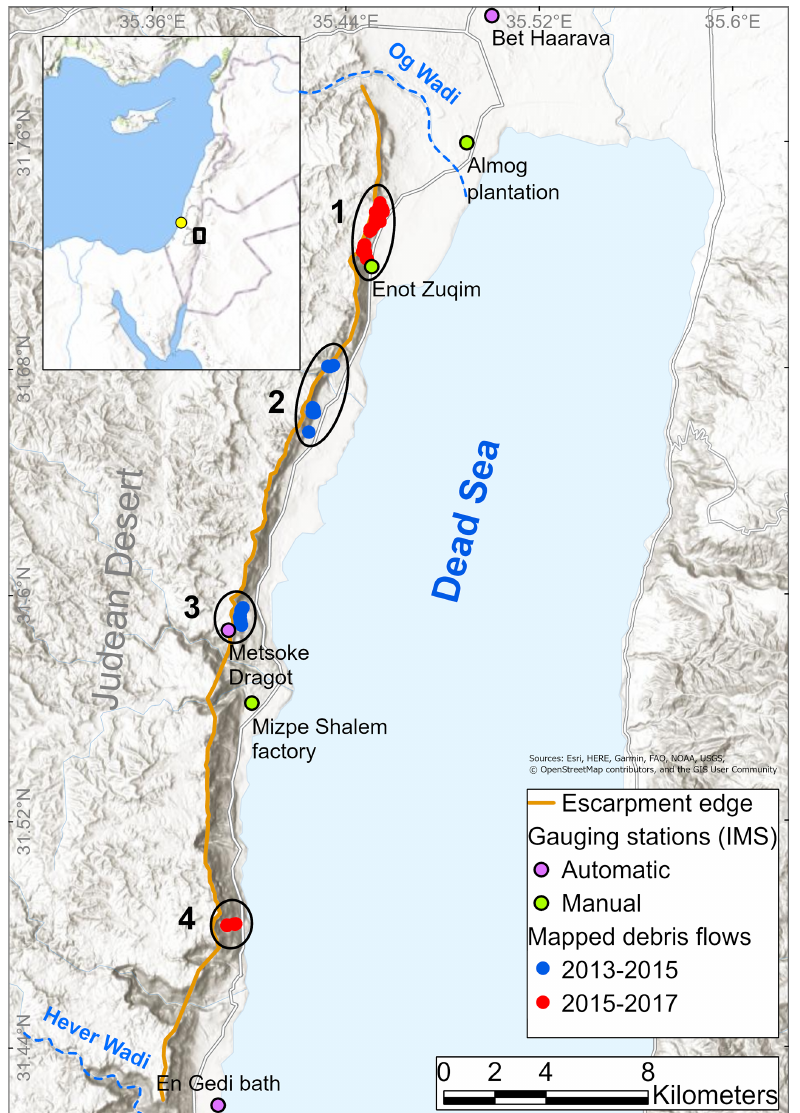
Figure 1. Map of the study area. An inset shows the location of the study area (black rectangle) and of the weather radar (yellow point) on a map of the eastern Mediterranean. The 43 DF deposits were mapped using elevation difference maps from the years 2013–2015 (in blue) and 2015–2017 (in red). The deposits were classified into four groups (black ellipse). Rain gauge stations of the Israel Meteorological Service are marked by purple and green points for automatic (10min) and manual (daily) stations,